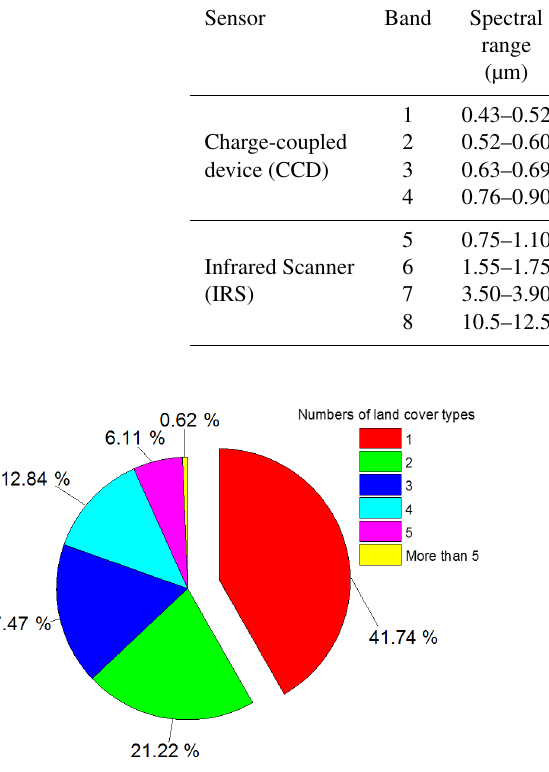
Figure 4. Percentage of the number of land cover types for the study at 300m scale with 30m land cover images.